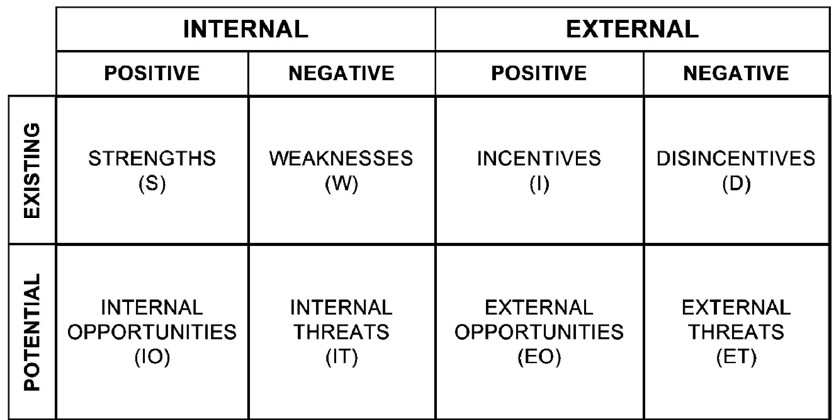
Figure 6. Groups in SWOT Plus [15,25,26]. Energies 2020 , 13 , x FOR PEER REVIEW